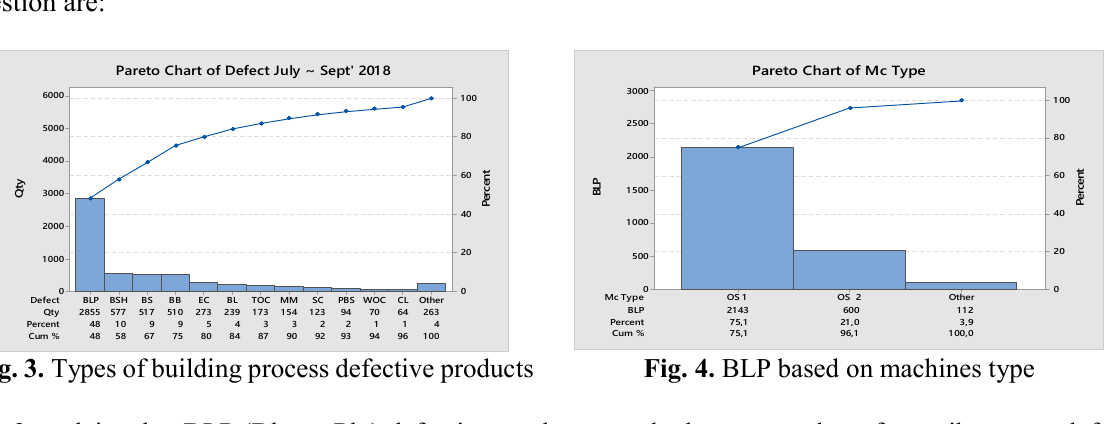
Performance baseline (sigma level) of building process July ~ September 2018